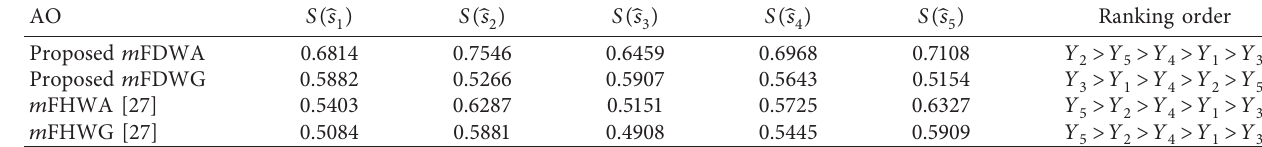
Table 6: Comparison of m F Dombi AOs with m F Hamacher AOs [27] in agriculture land selection. AO